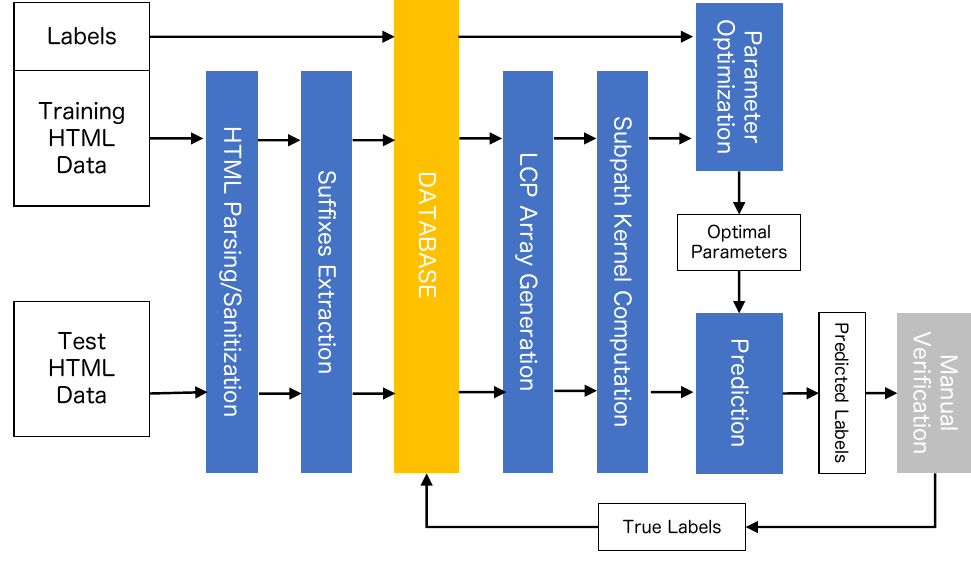
Figure 11. The overall process